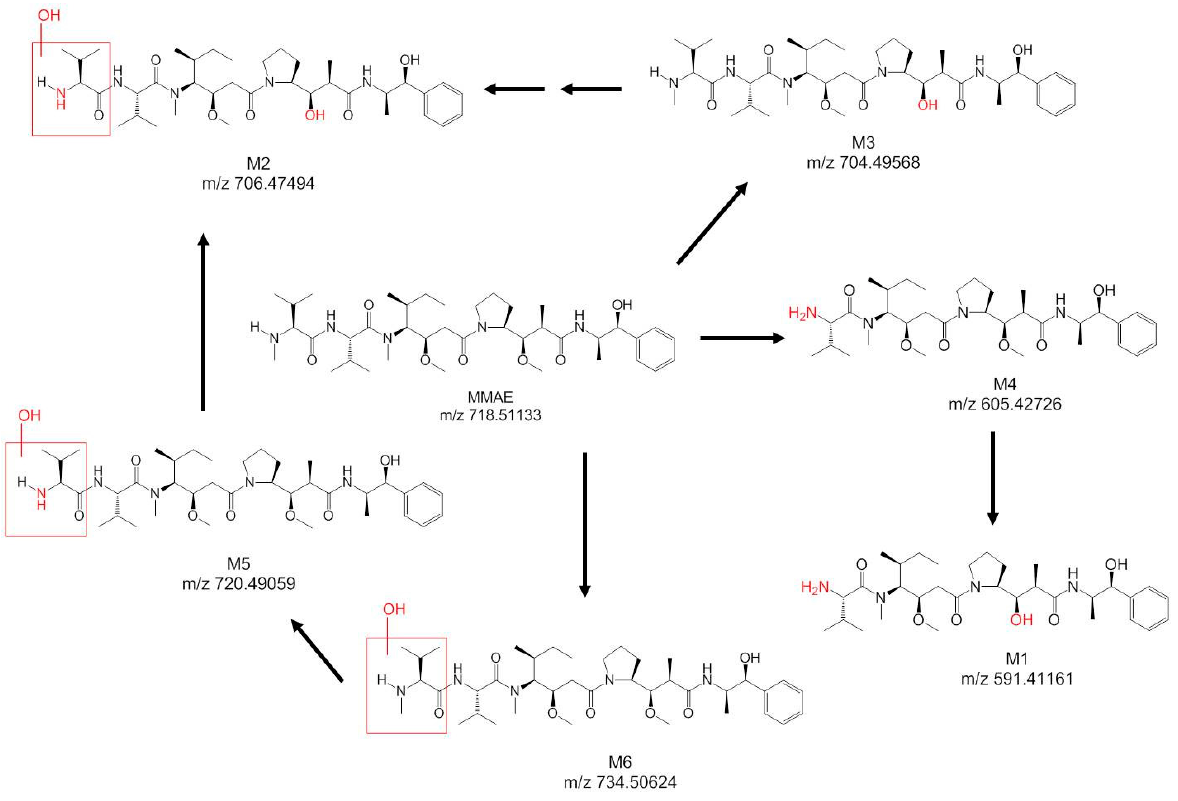
Figure 4. Structure of MMAE and its metabolites identified, with the possible biotransformations in the rat bile samples dosed with [ 3 H]-MMAE.